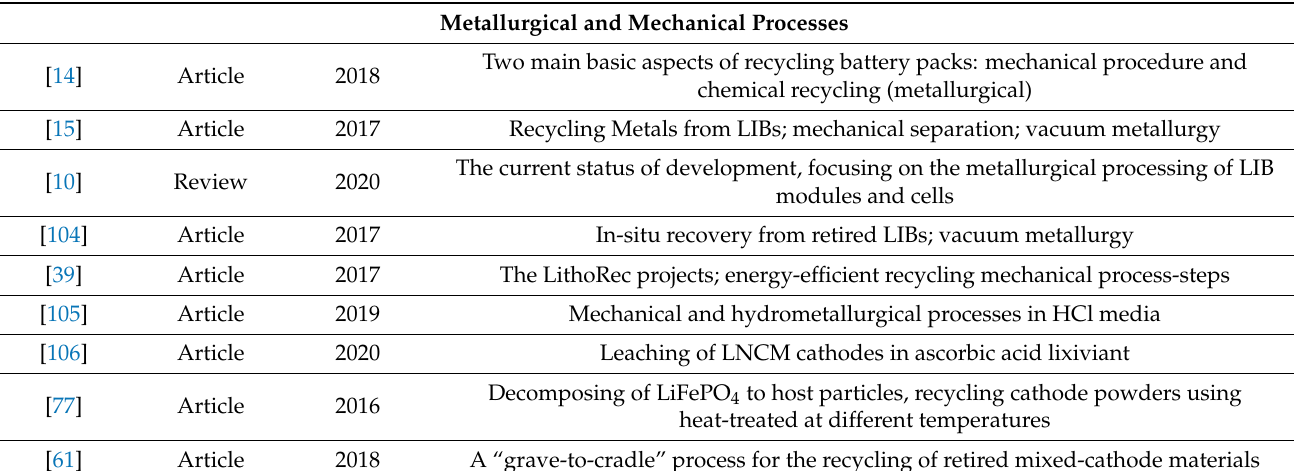
Table A2. Assessed literature in review for “Metallurgical and Mechanical Process” category.